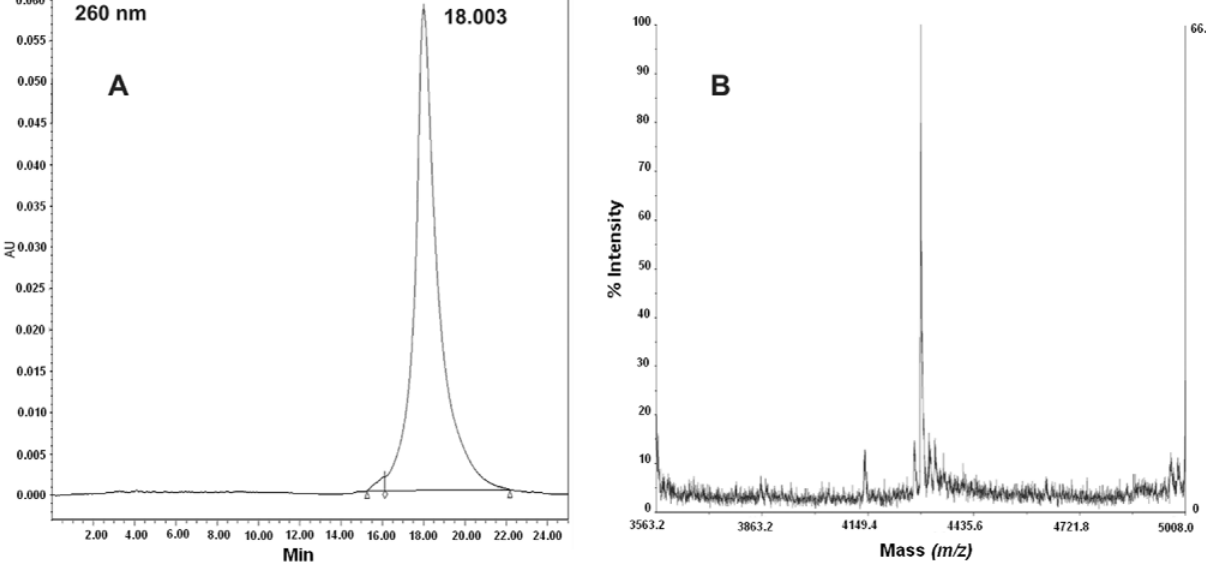
Figure 1. ( A ) RP-HPLC of purified PNA-RPOB15wt. Conditions used: Vydac analytic C18 monomeric 238TP54 (5 μ m, 300 Å, 4.6 × 250 mm); ( B ) Deconvoluted ESI-TOF